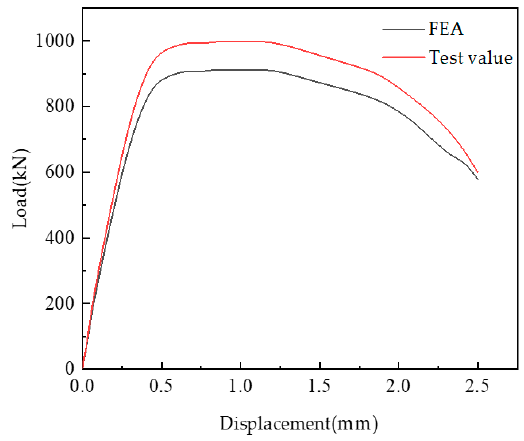
Figure 14. Load-displacement curve of test piece.